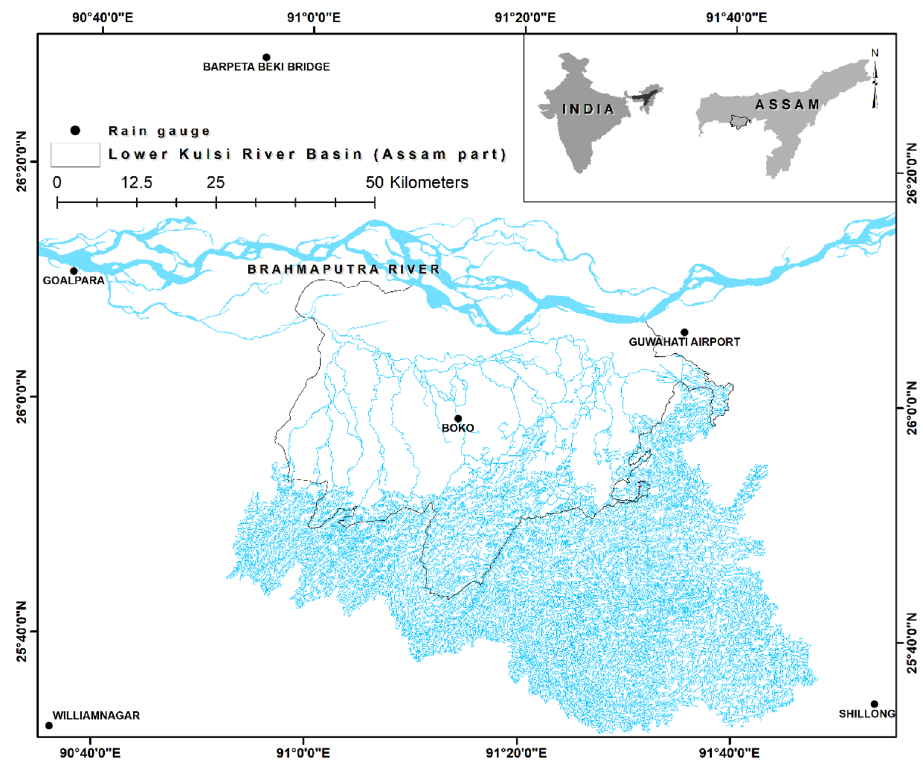
Fig. 1 Location map of the lower Kulsi River